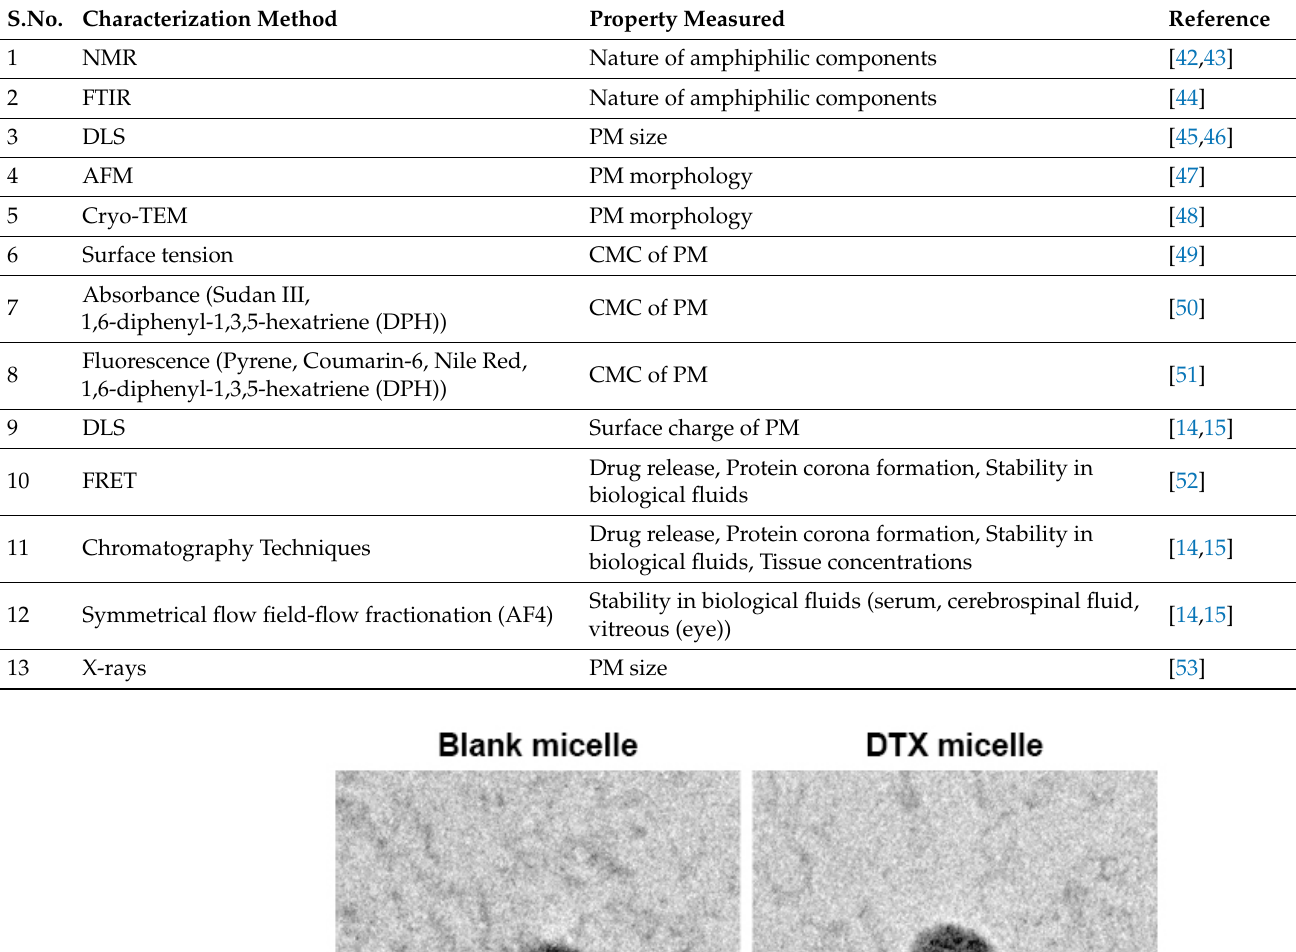
Table 1. Characterization techniques used in measuring various PM properties.